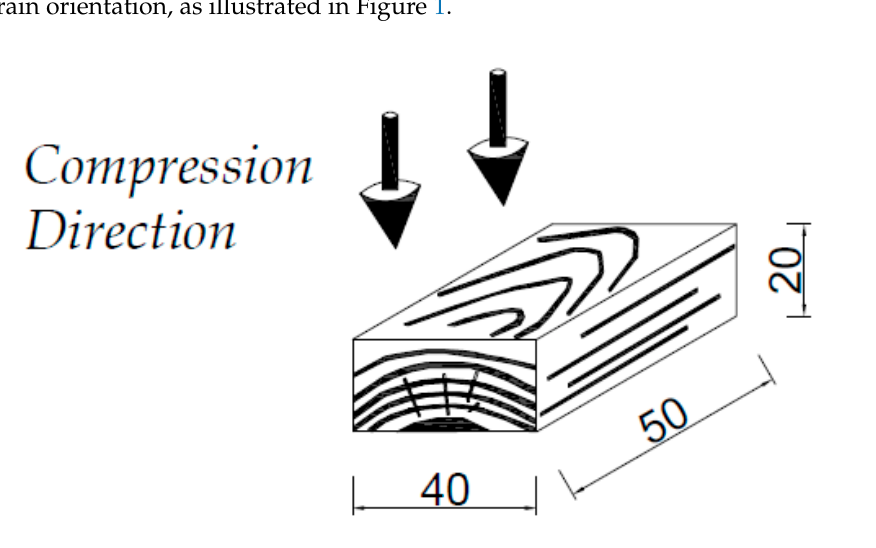
Figure 1 . Compression direction and sample size (mm) before densification. Figure 1. Compression direction and sample size (mm) before